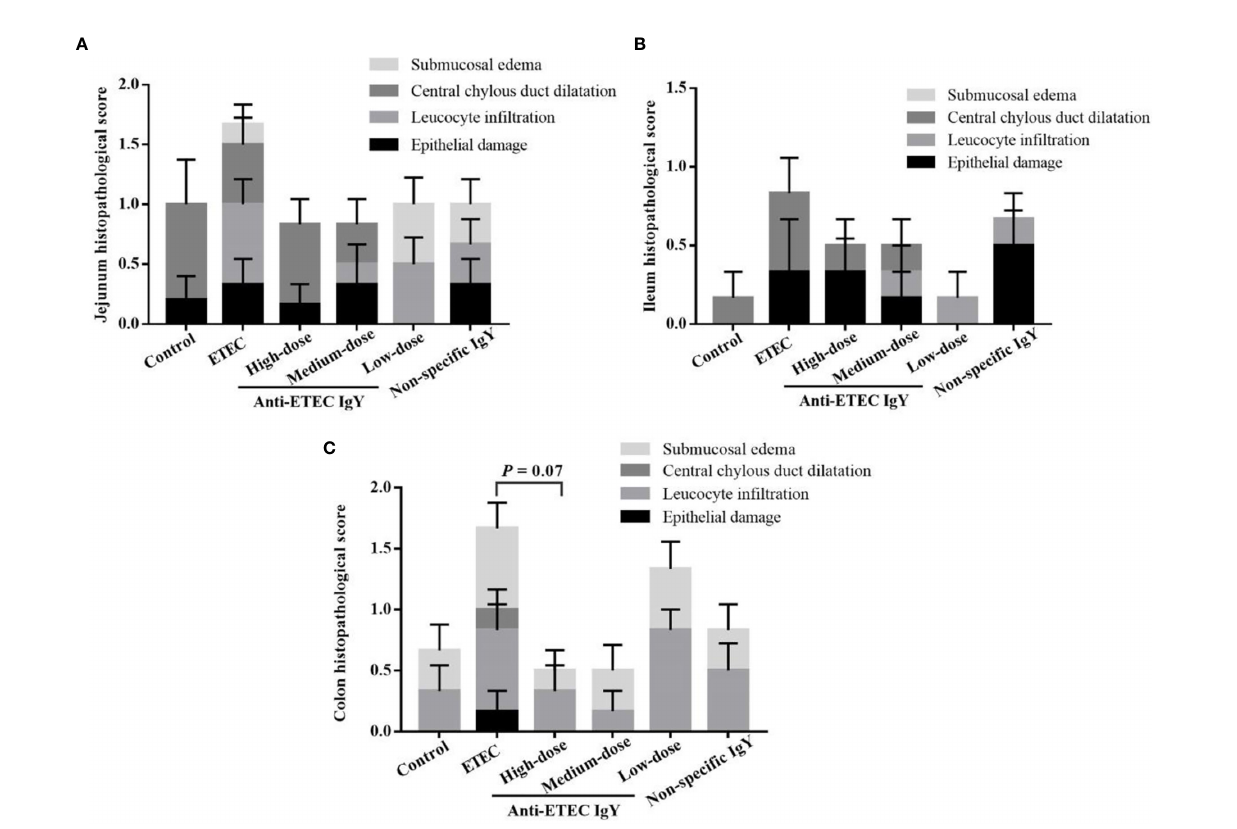
FIGURE 8 | Pathological score of jejunum (A) , ileum (B) and colon (C) tissues in control (neither IgY nor ETEC K88 infection) mice, ETEC-infected mice, ETEC- infected mice treated with 250 m L of high-dose (32 mg/mL), medium-dose (16 mg/mL) or low-dose (8 mg/mL) anti-ETEC K88 IgY, or ETEC-infected mice treated with 250 m L of non-speci fi c IgY (16 mg/mL). Figures are four different graphs laid on top of each other. Pathological scores were assessed according to the following degrees: 0, none;1, mild; 2, moderate; 3, severe. Data are presented as least squares mean ± SEM,